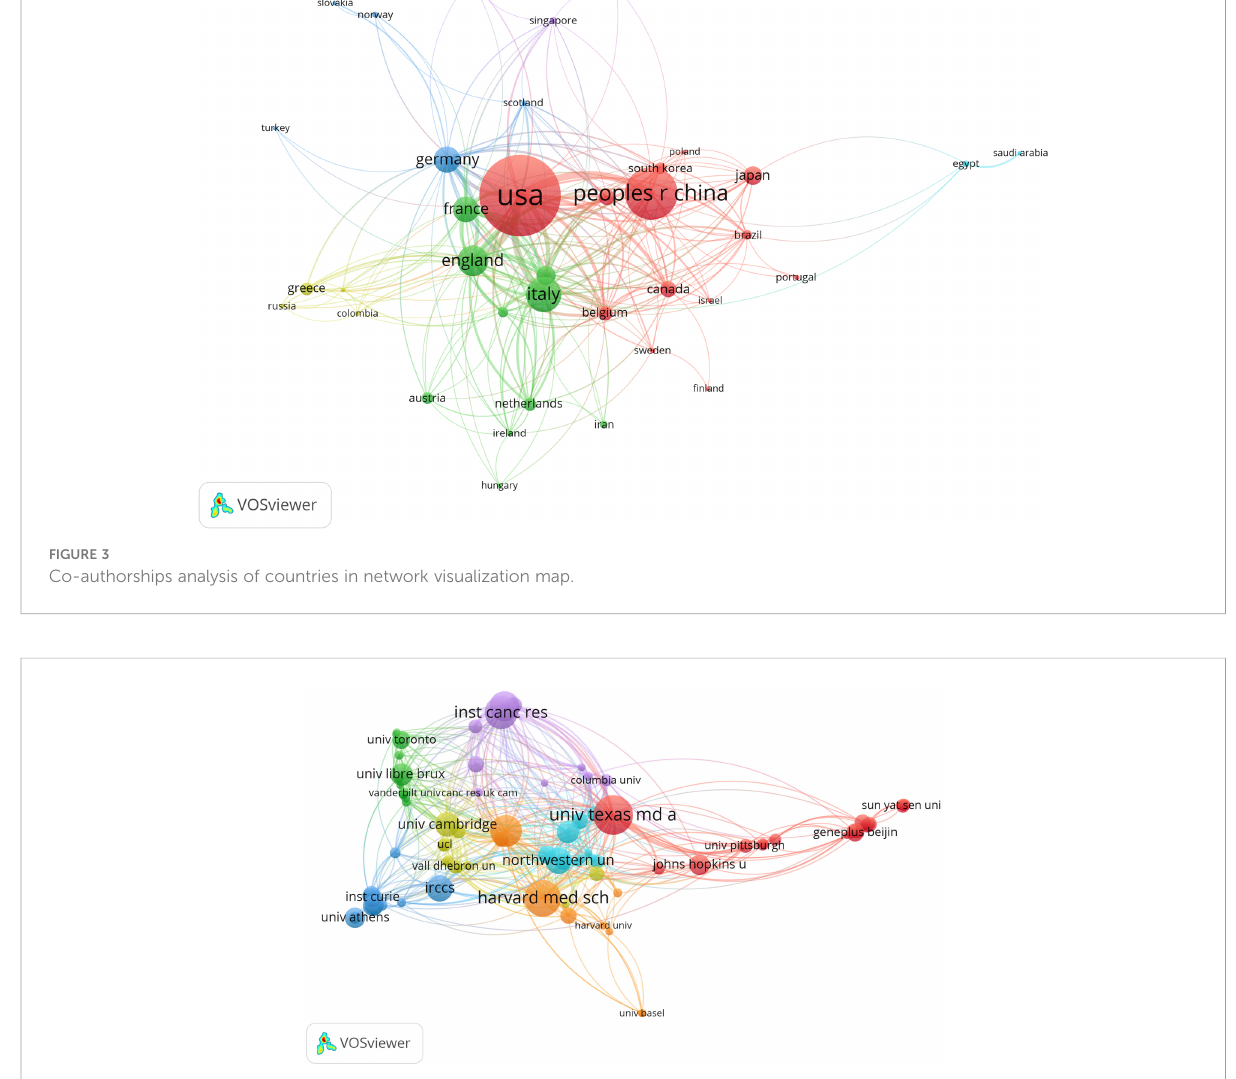
FIGURE 4 Co-authorships analysis of organizations in network visualization map.